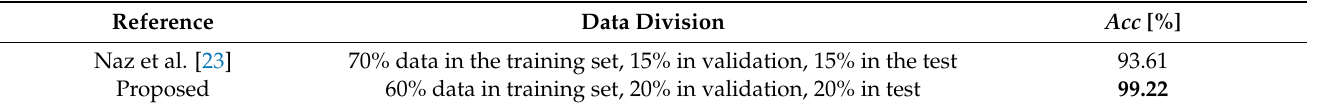
Table 5. Comparing the results of different network architectures trained on the original database and performance were tested via one test record-wise method.